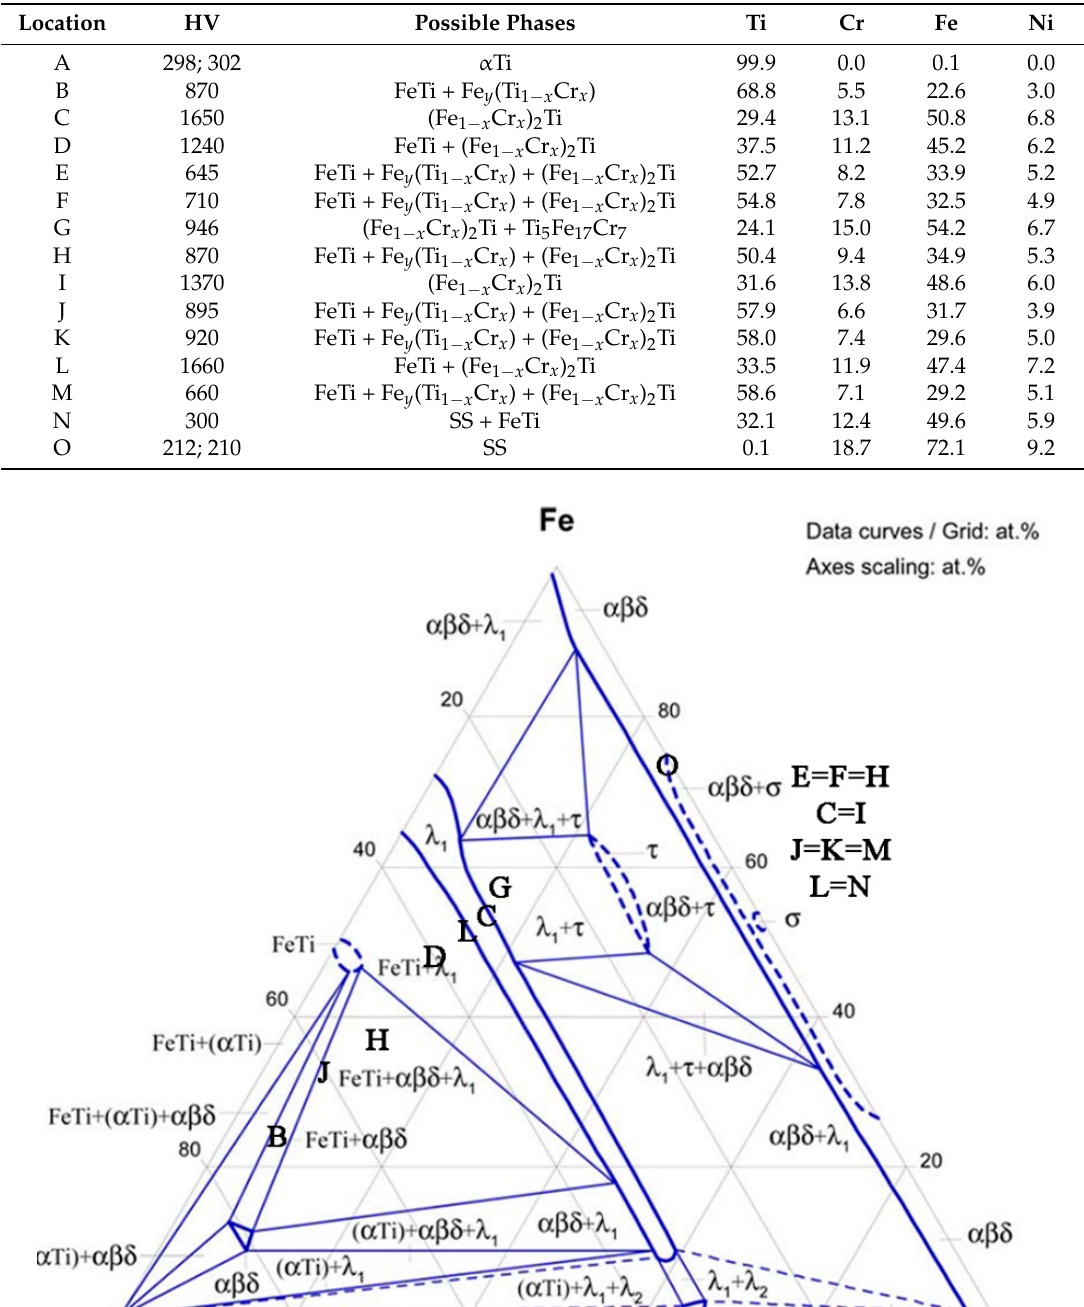
Figure 5. ( a ) Backscattered electron image and ( b ) chemical composition (at.%) of the area along the scanned line of LBW weld profiles. Table 2. Correlation between hardness, chemical composition and possible phases across the LBW profile. The label A-O corresponds to Figure 3, and the corresponding chemical composition is overlaid in Figure 6 [11].